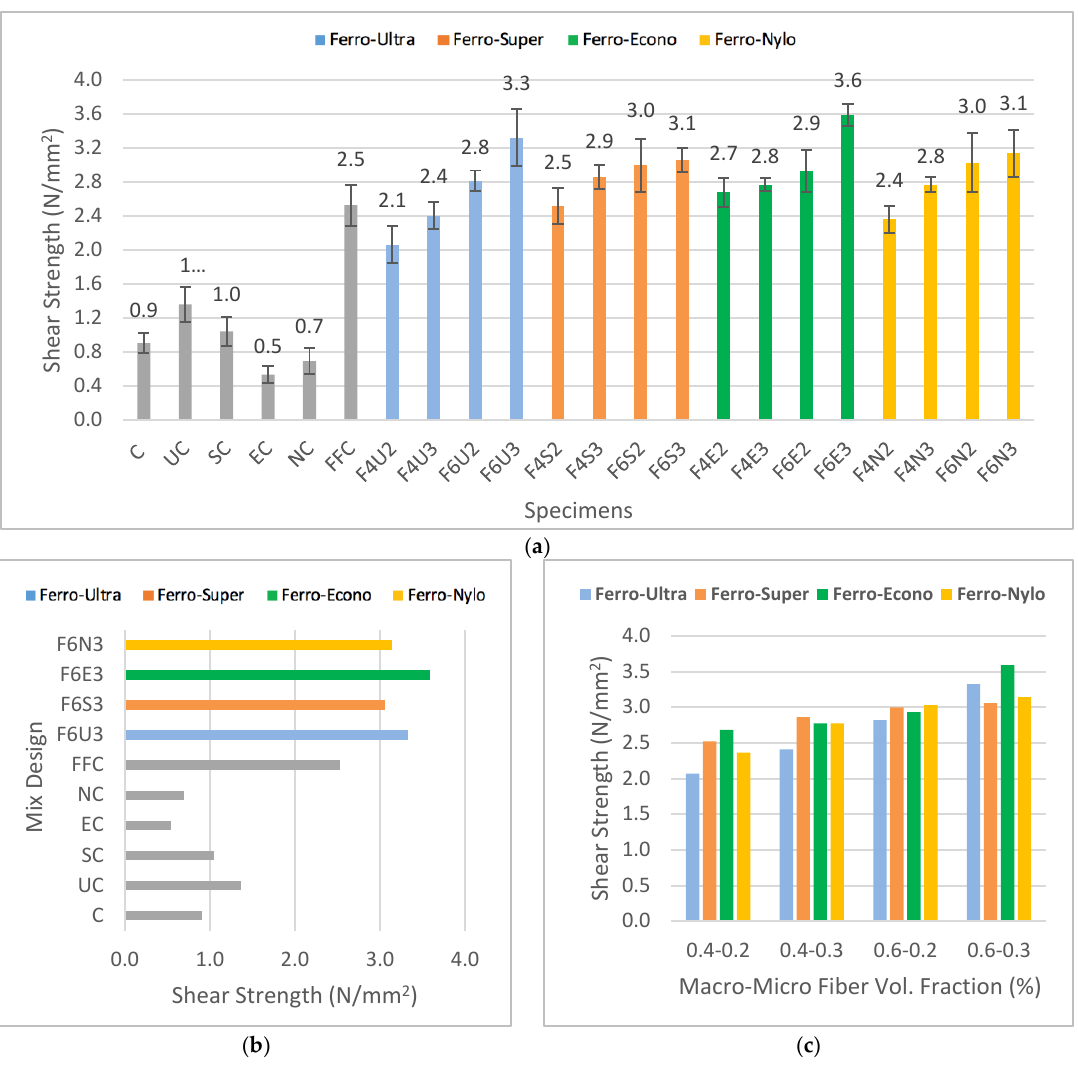
Figure 4. The shear strength of ( a ) developed HyFRC with error bars, ( b ) control vs. HyFRC specimens, and ( c ) HyFRC categorized by fiber dosage.